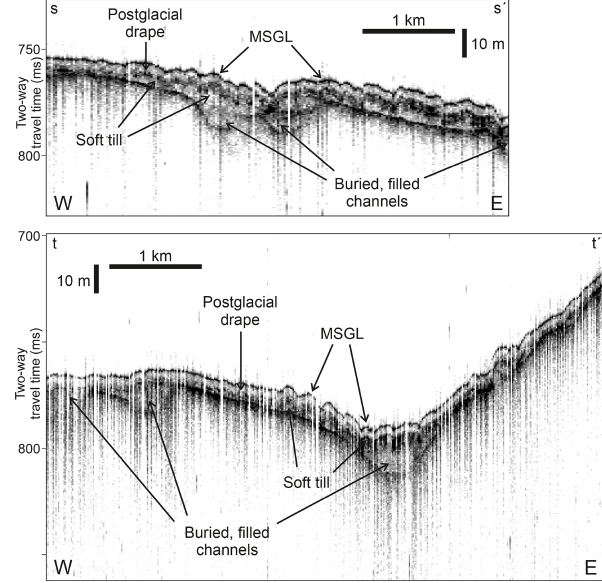
Figure 4. Acoustic sub-bottom (TOPAS) profiles from the southern part of Anvers-Hugo Trough showing buried, filled channels over- lain by acoustically transparent “soft till” layer with MSGLs on its surface, which is in turn overlain by a thin drape of postglacial sed- iments. Locations of profiles shown in Fig.